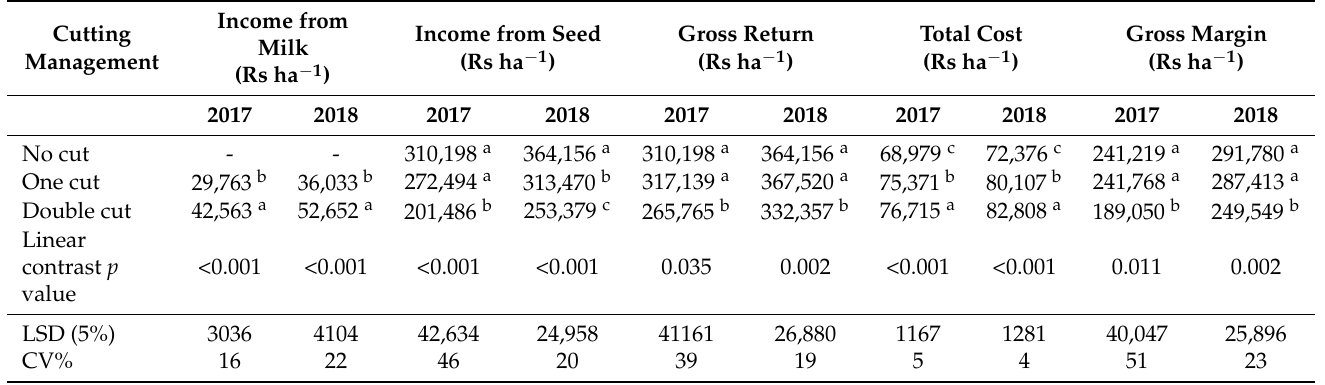
Table 3. Effect of cutting management on the gross margin for a teosinte seed crop in 2017 and 2018 at NCRP, Chitwan, Nepal (NRs. = Nepalese